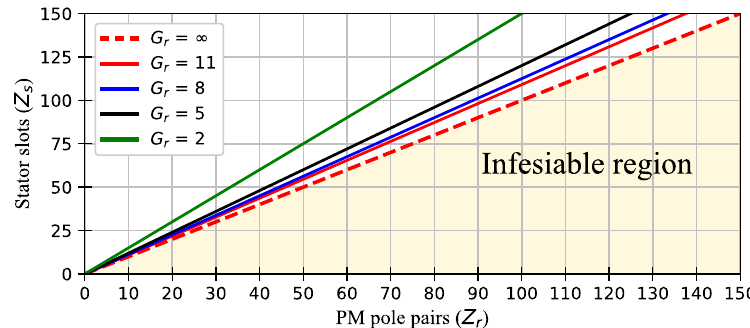
Figure 3. Gear ratio G r as a function of Z s and Z r . Table 1. Design Parameters.